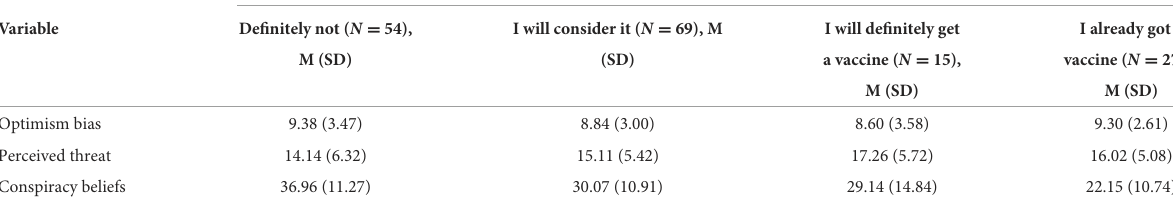
TABLE 1b Descriptive statistics for the main variables depending on participants’ vaccination intention/status. Vaccination intention/status